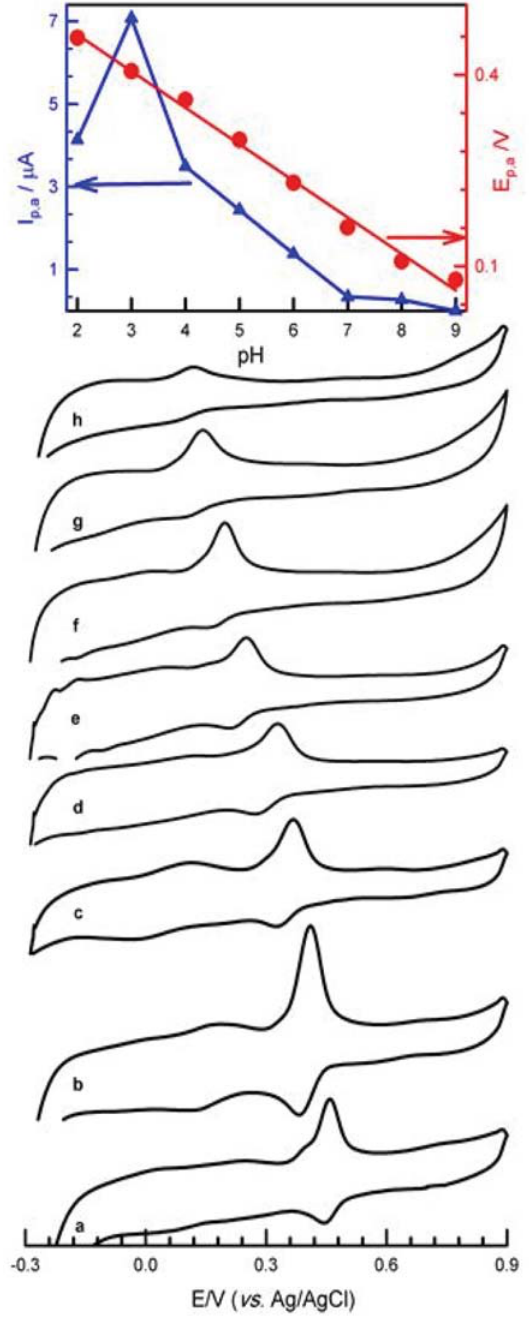
Figure 4 . Cyclic voltammograms of 60 μM LD at the PDB/MWCNTs-GCE in 0.11 mol L –1 PBS at pH (a) 2.0, (b) 3.0, (c) 4.0, (d) 5.0, (e) 6.0, (f) 7.0, (g) 8.0 and (h) 9.0. The scan rate is 0.100 V s –1 . Also, the plots of the extracted I shown